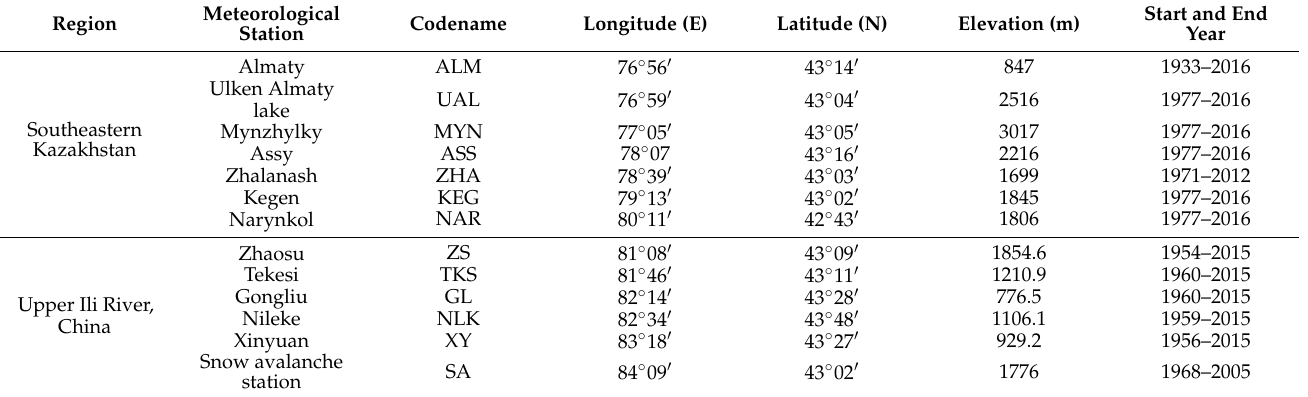
Table 2. Basic information about the meteorological stations.